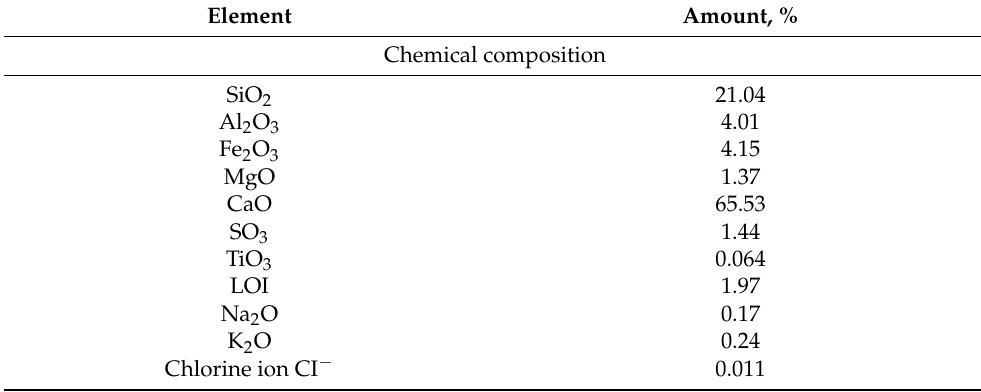
Table 4. Chemical composition of cement.